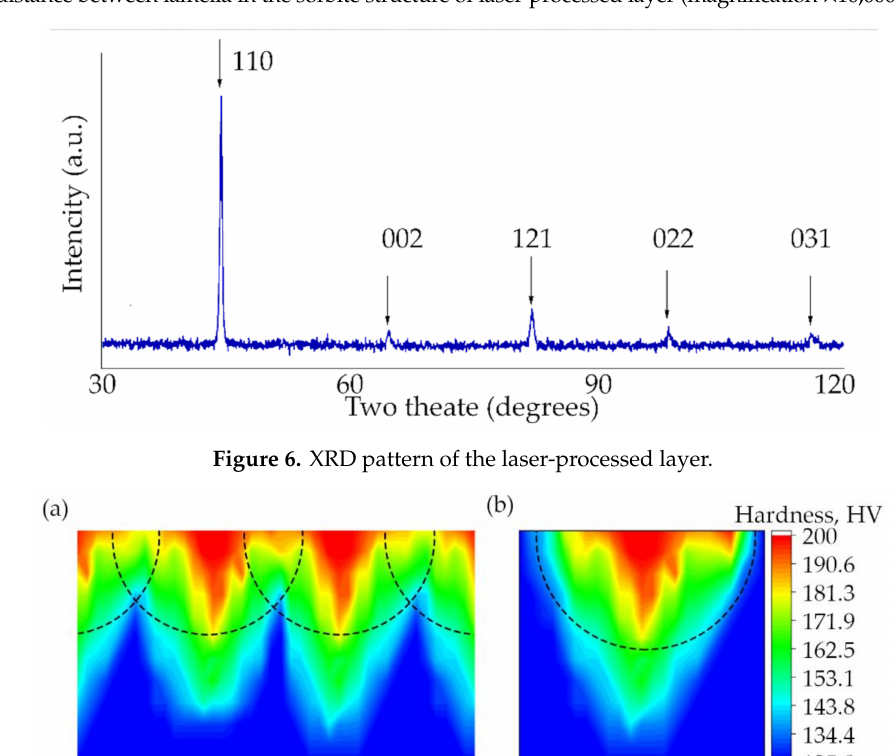
Figure 7. Distribution of hardness through the cross-section of the laser-processed surface of sample IIA: ( a ) and ( b ) show the distributions of three- and one-laser-processed tracks